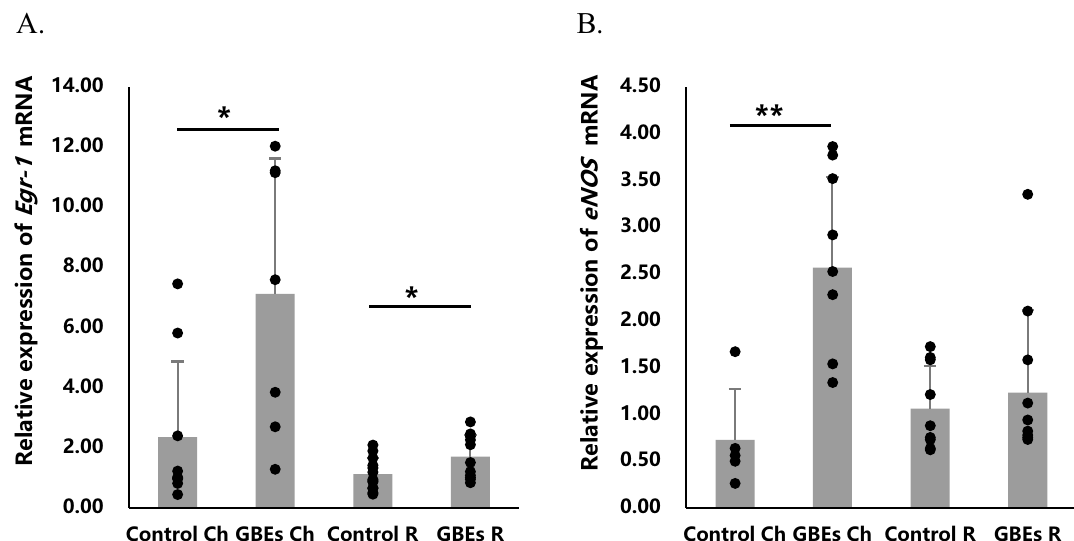
Figure 4. The mRNA expression of Egr-1 and eNOS was significantly upregulated in the choroid by GBEs administration. ( A ) Egr-1 mRNA expression showed a significant increase in the choroidal and retinal samples after 3 weeks of oral GBEs administration, compared to the normal chow-fed control group ( p < 0.05) (n = 8). ( B ) eNOS mRNA expression also showed a significant increase in the choroid after 3 weeks of GBEs feeding compared to the control group ( p < 0.01) (n = 8). * p < 0.05, ** p < 0.01, bars represent mean + / − standard deviations. Ch: choroid; R: Retina; GBEs: Gingko biloba extracts.